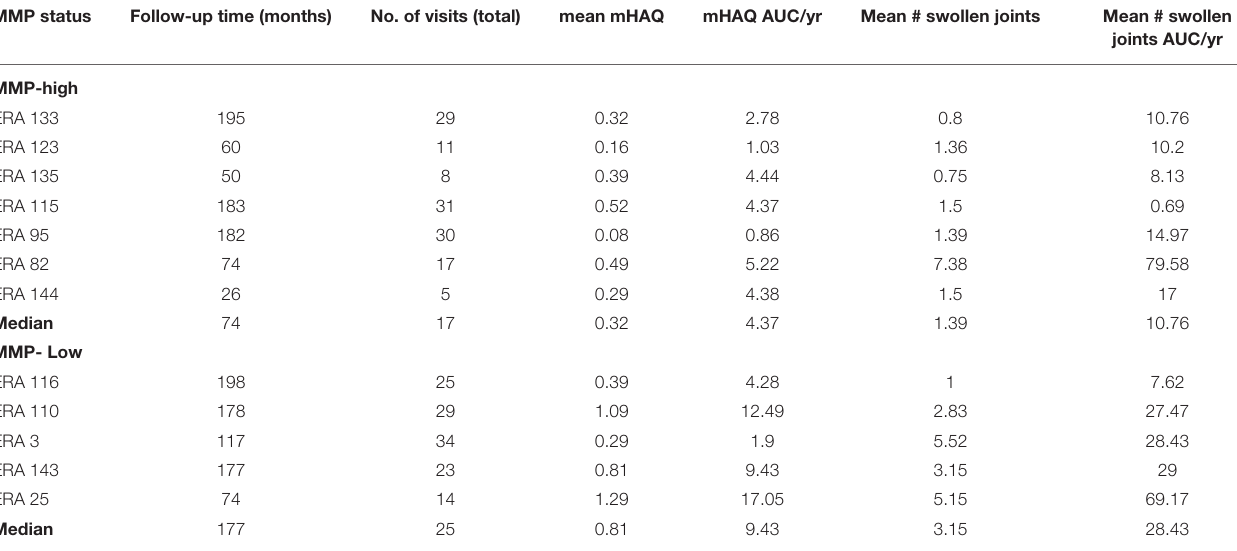
TABLE 2 | Long-term clinical outcomes in MMP-high and MMP-low DMARD-naïve EIA patients. MMP